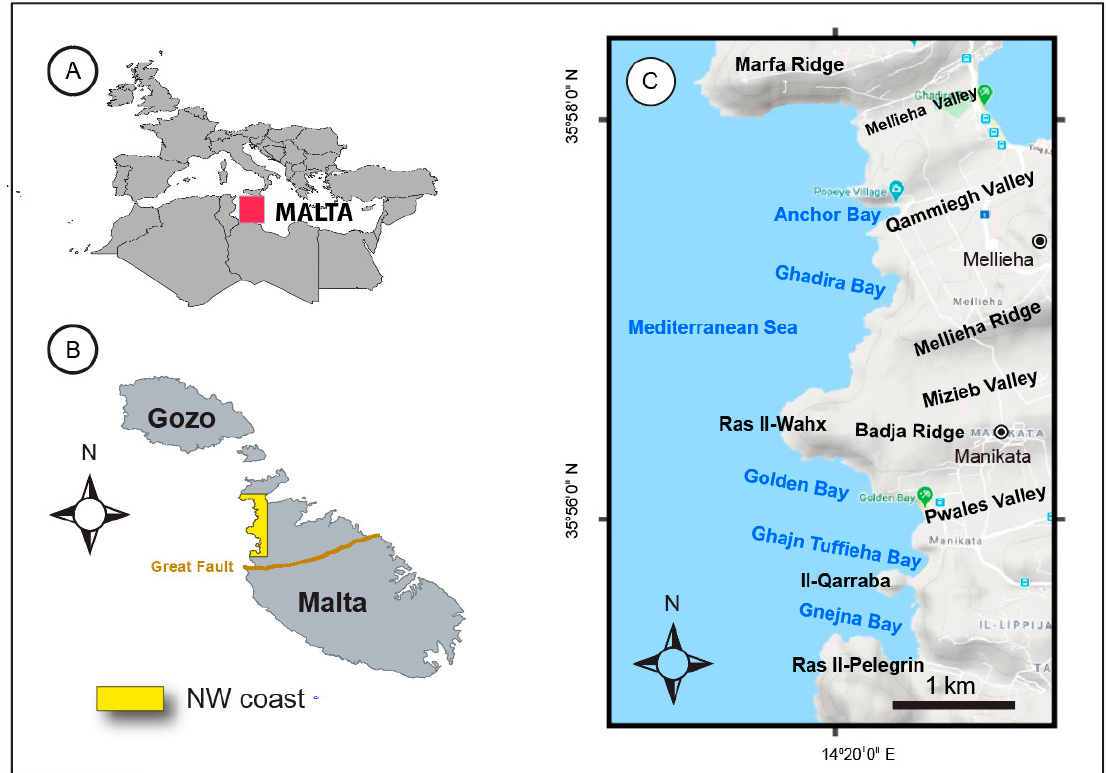
Figure 1. ( A ) Location of Malta; ( B ) Map of the Maltese islands; and ( C ) Relief map of the northwestern sector of Malta.